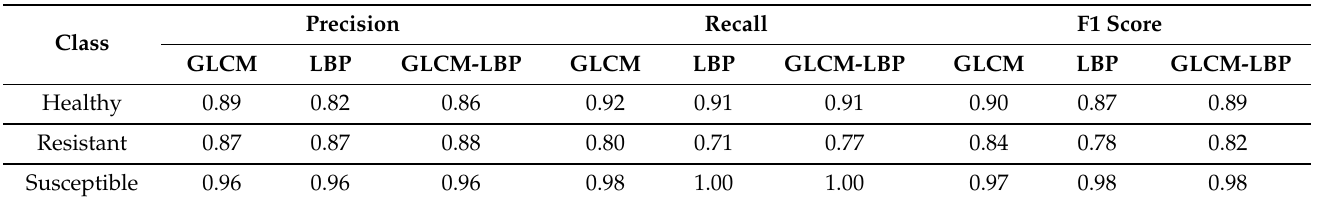
Figure 6. Confusion matrix of Decision Tree on GLCM, LBP, and combined texture GLCM-LBP images. Similarly, Table 3 shows class-wise precision, recall, and F1 score of Random Forest on GLCM, LBP, and combined texture GLCM-LBP images. It is observed that Random Forest achieved the highest accuracy of 90.96% and 90.30% on the GLCM texture images and combined texture GLCM-LBP images, respectively, where the minimum accuracy of 88.62% was observed on LBP texture images. Random Forest performed well on all types of texture images than compared to the performance of Decision Tree, where small precision, recall, and F1 score values were observed for healthy and resistant infection types in the case of LBP texture images. However, Random Forest shows high precision, recall, and F1 score values in the case of healthy and resistant images on LBP texture images than compared to the performance of Decision Tree on LBP texture images with these evaluation metrics. Table 3. Performance comparison for Random Forest classification on GLCM, LBP, and combined textures GLCM-LBP